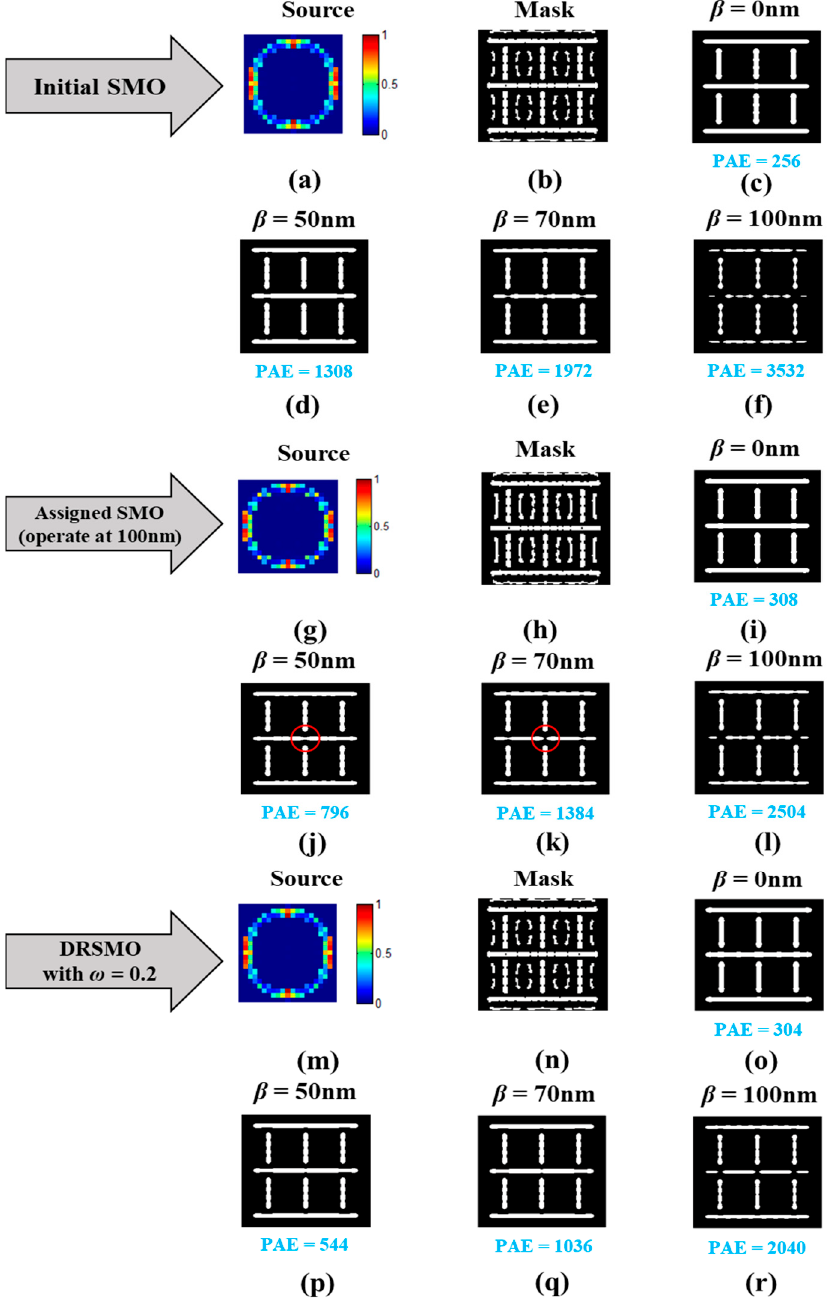
Figure 3. Target 2 simulation results of the initial SMO, SMO under assigned focus plane (100 nm defocusing), and DRSMO with ω = 0.2, respectively.